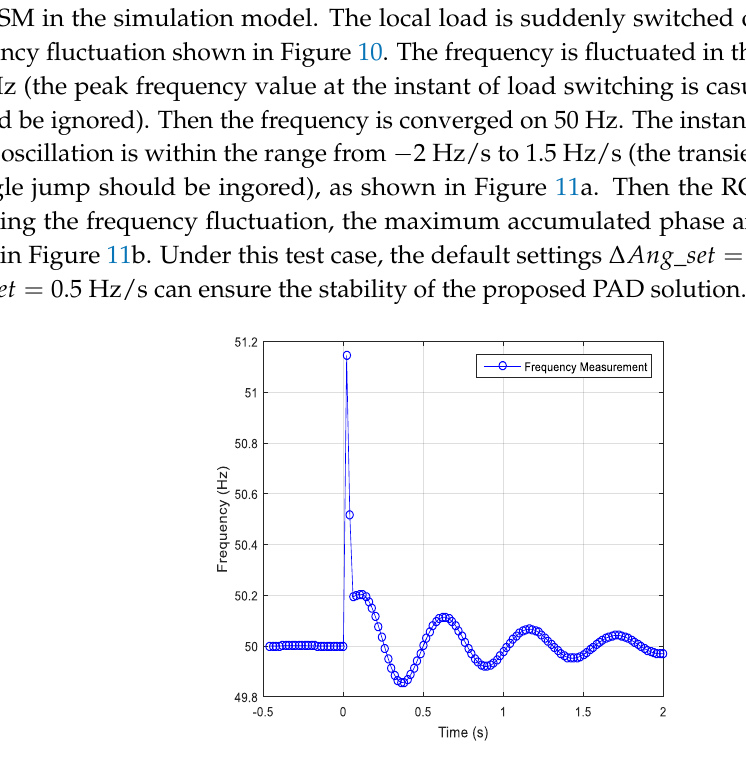
Figure 10. Frequency measurement under the frequency fluctuation after large load switching off.